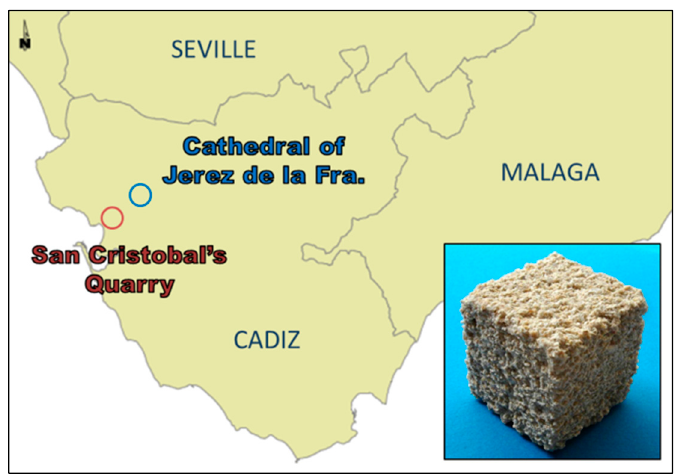
Figure 1. Geographical location of the San Cristobal Quarry and the Cathedral of Jerez de la Frontera. The biocalcareous stone under study is shown in the inset.